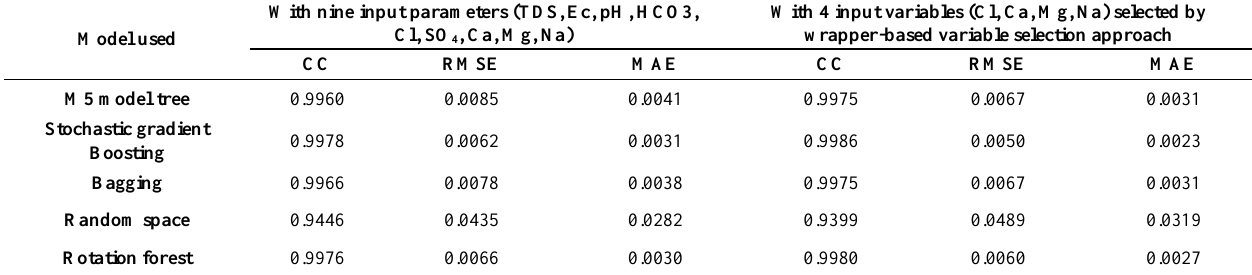
Table 5. Values of different statistical measures obtained using different ensemble approaches with M5 model tree with different input variables. Model